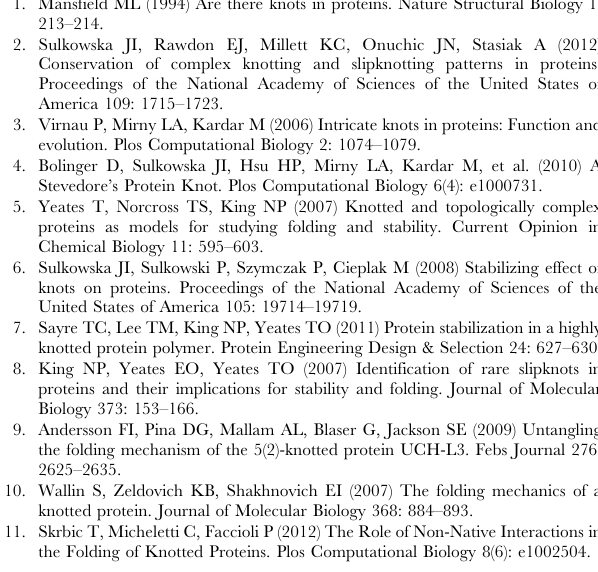
Figure S5 Pathway leading to dead-end conformations when the chain is tethered to the surface via the N-terminus. Each conformation with fraction of native contacts Q is the closest to the cluster’s centroid, i.e., the cluster’s representative. The residues colored in orange have at least two of its native contacts formed. In parenthesis we show the ratio between the size of the cluster (its number of conformations) and the initial ensemble with fraction of native contacts Q . (TIF) Figure S6 Pathway leading to dead-end conformations when the chain is tethered to the surface via the C-terminus. Each conformation with fraction of native contacts Q is the closest to the cluster’s centroid, i.e., the cluster’s representative. The residues coloured in orange have at least two of its native contacts formed. In parenthesis we show the ratio between the size of the cluster (its number of conformations) and the initial ensemble with fraction of native contacts Q. (TIF) Figure S7 Another folding pathway leading to dead-end conformations when the chain is tethered to the surface via the C-terminus. Each conformation with fraction of native contacts Q is the closest to the cluster’s centroid, i.e., the cluster’s representative. The residues coloured in orange have at least two of its native contacts formed. In parenthesis we show the ratio between the size of the cluster (its number of conformations) and the initial ensemble with fraction of native contacts Q .